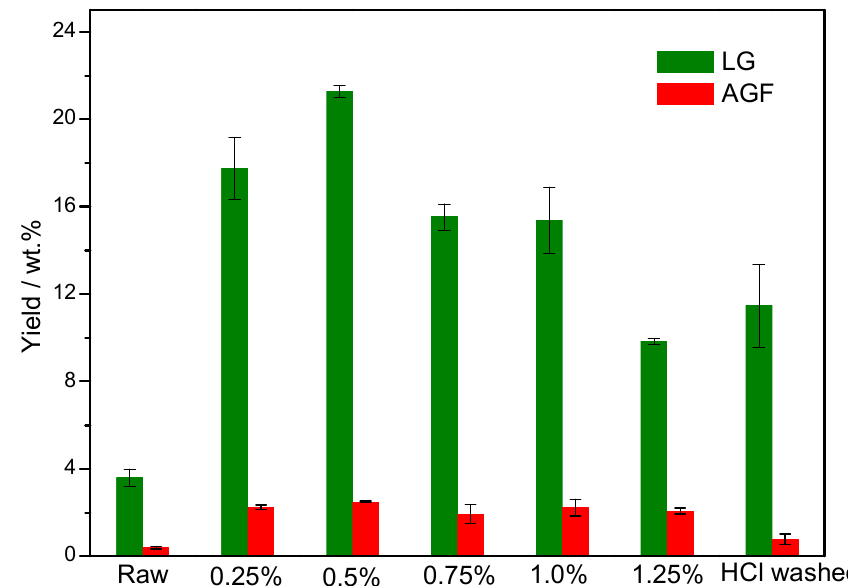
Figure 3. The yields of levoglucosan (LG) and AGF from fast pyrolysis of raw and H 2 SO 4 -impregnated eucalyptus.